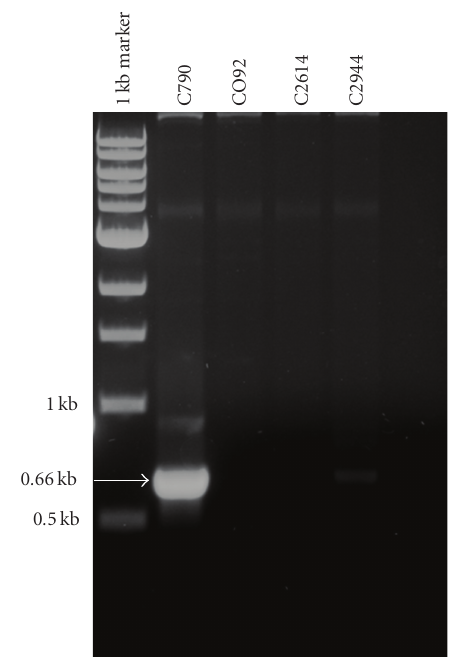
Figure 4: PCR amplification one of the two junctions between pMT1 and pCD1 in strain C790 which has pMT1-pCD1 chimera